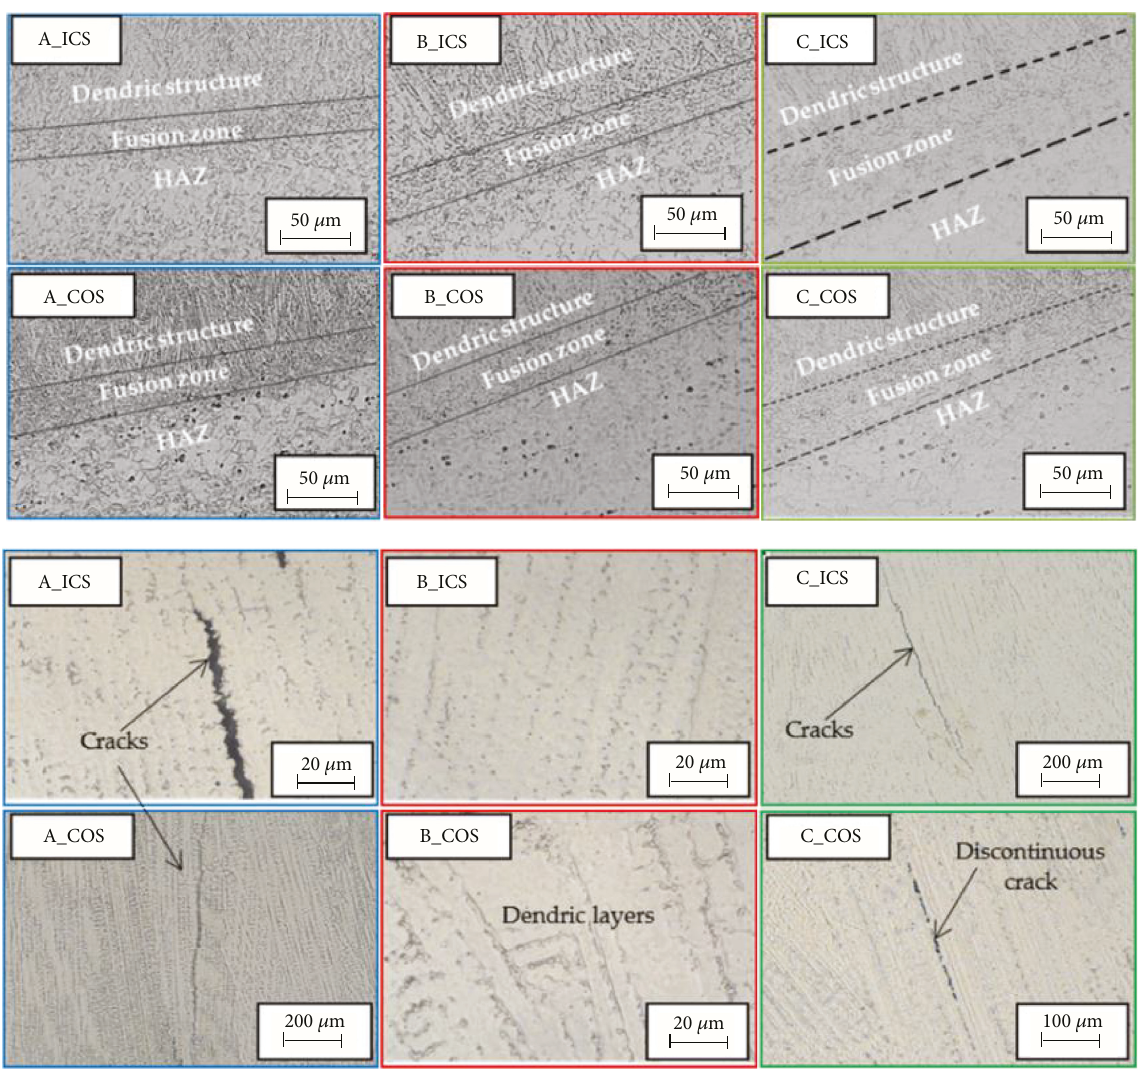
Figure 6: Optical microscopic images. Microstructure of substrate (base plate) in cross-sectional view and transition grain structure of the IN718 wall for ICS and COS using both processing parameters. Micrograph of dendritic structure for the ICS and COS